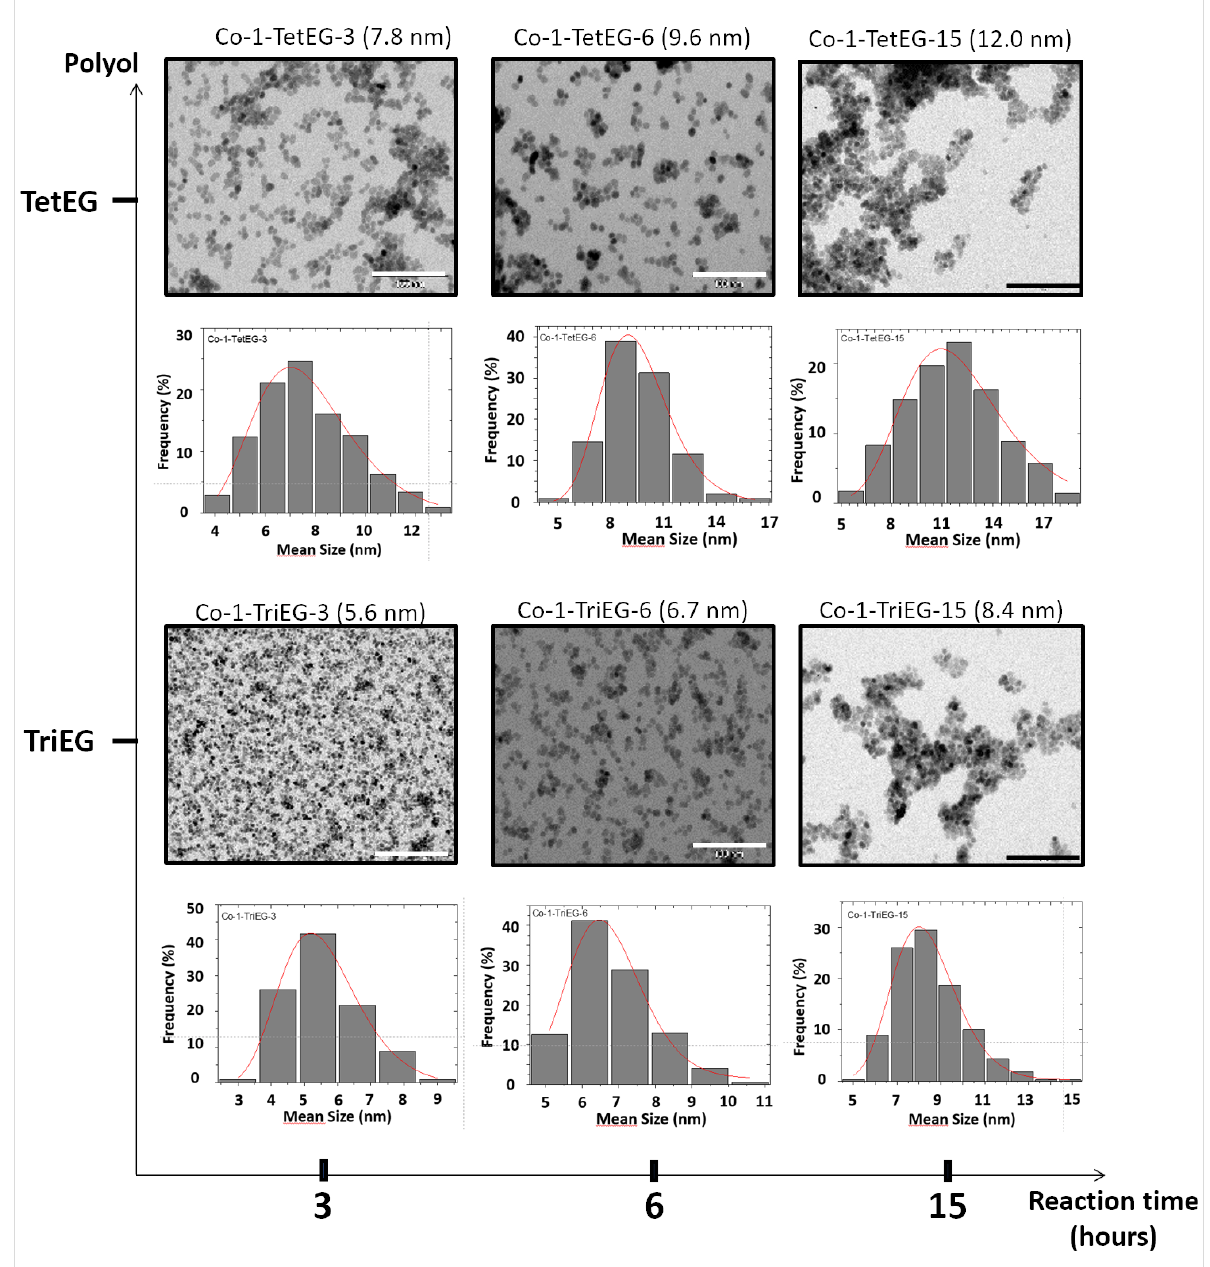
Figure 3: TEM images of CoFe 2 O 4 NPs as a function of the polyol nature and the reaction time, and the corresponding diameter distributions and log- normal fits. Scale bar = 100 nm.